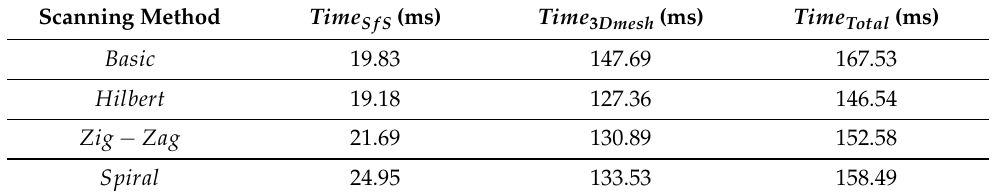
Table 6. Three-dimensional (3D) image reconstruction processing time using SFS and Algorithm A3. Scanning